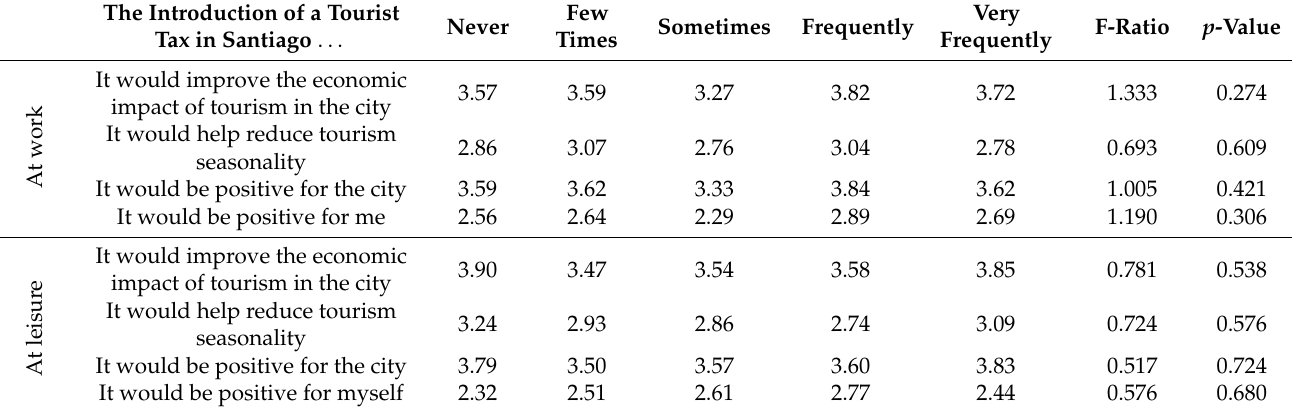
Table 3. Perception of the implementation of the tourist tax according to contact with visitors (work or